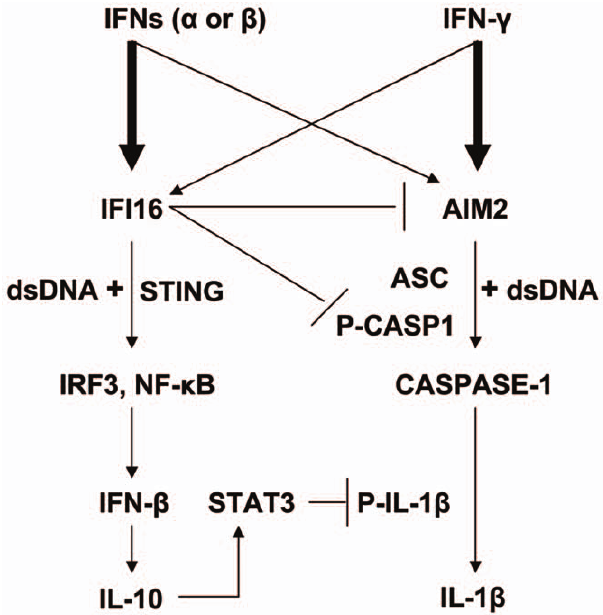
Figure 7. Type I and type II IFNs differentially regulate the expression of the IFI16 and AIM2 proteins. The expression of IFI16 protein suppresses activation of caspase-1 by the AIM2 inflammasome.